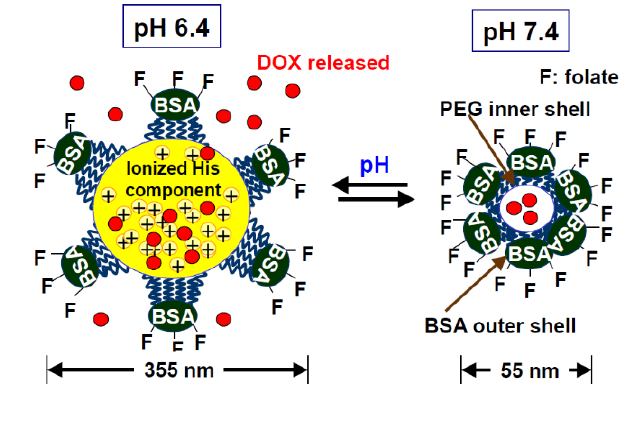
Figure 2. Virus-mimetic nanogel system. The virus-like infectious nanogel consists of a hydrophobic core [poly(His- co -Phe)] and two layers of hydrophilic shells [(PEG and BSA)]. Reproduced with permission from